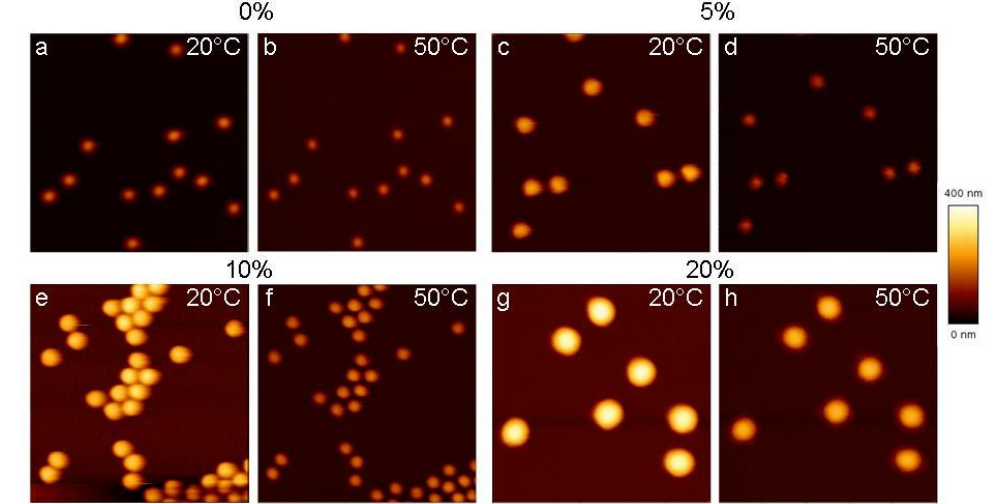
Figure 2. SFM height images of microgel particles with 0% (a, b) , 5% (c, d) , 10% (e, f) and 20% (g, h) AAc content deposited on gold wafer. Images were taken in SFM liquid cell at 20 ◦ C (a, c, e, g) and at 50 ◦ C (b, d, f, h). Scan area: 5 × 5 (cid:22) m 2